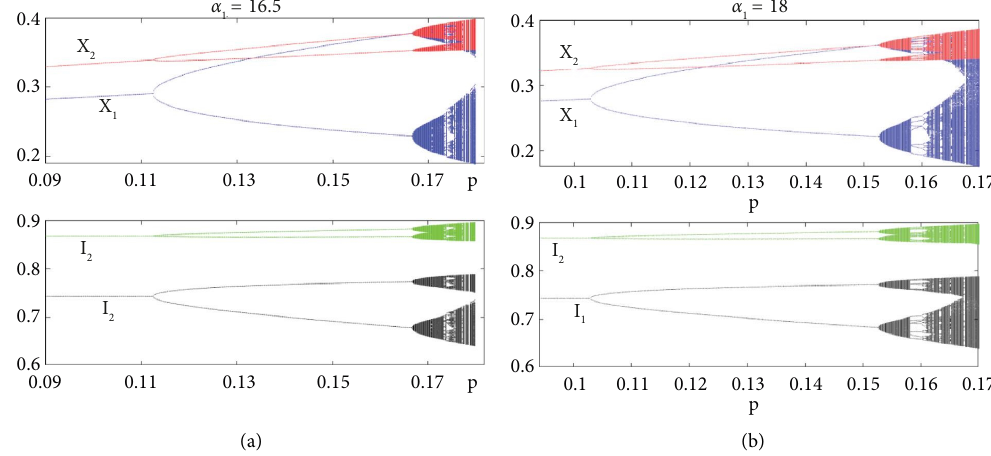
Figure 4: Te bifurcation diagram of the discrete dynamic system (8) with the market price P of the credits transaction under the at diferent R&D investment. adjustment speed α 1